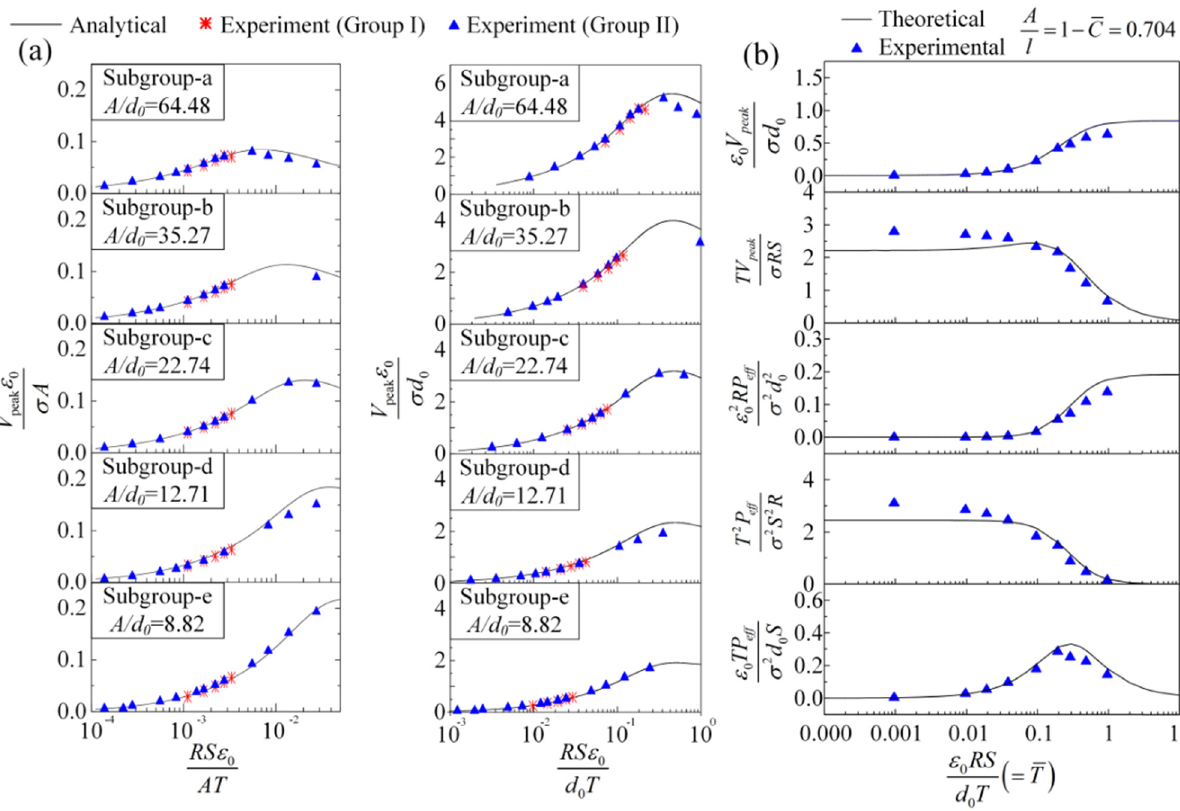
Figure 6: ( a ) Validation of the scaling laws for dimensionless peak output voltage through comparisons with experimental measurements with di ff erent setups for contact - mode TENGs, and ( b ) comparison between theoretical results and experimental results for sliding - mode TENGs [ 54,55 ]